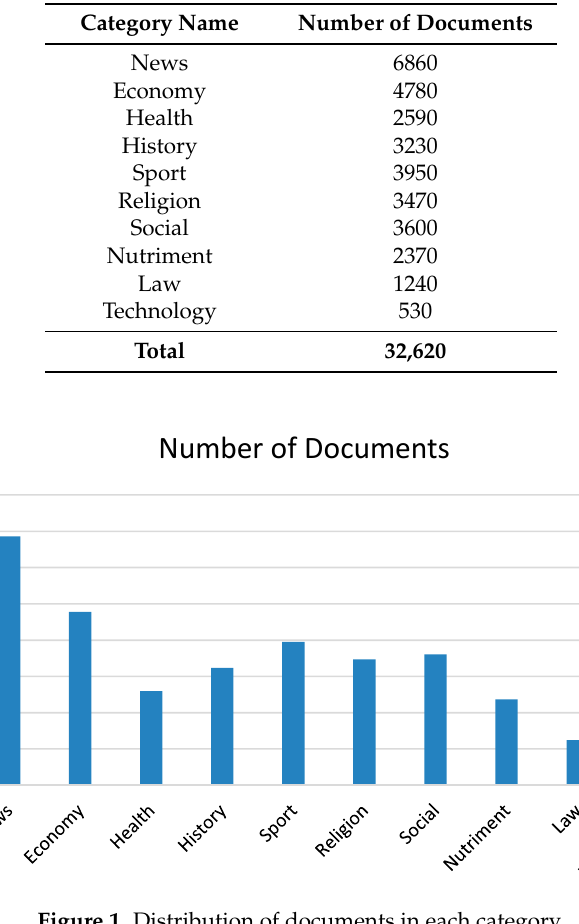
Figure 1. Distribution of documents in each category.